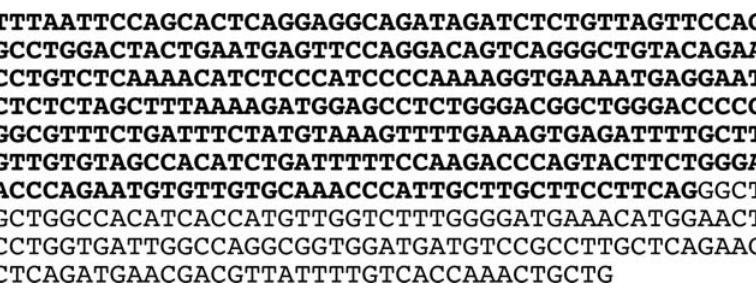
Figure 7. Sequence of 5 9 RACE product defining new mRNA start site from mouse brain. Sequence in bold is the newly defined 5 9 UTR which corresponds to the region previously assigned to be the intron between Exons 4 and